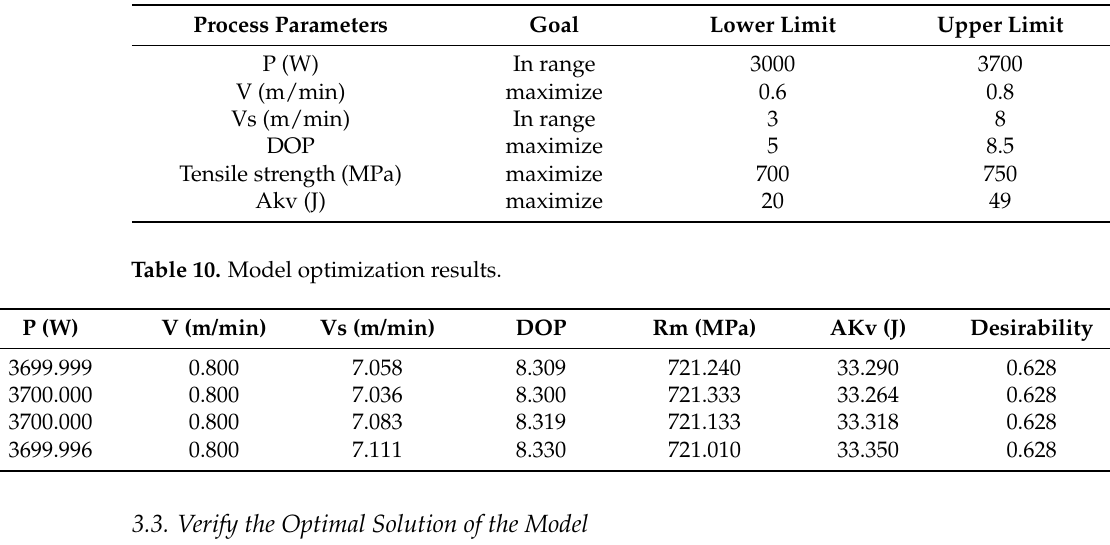
Table 9. The model optimization scheme of impact absorption energy.